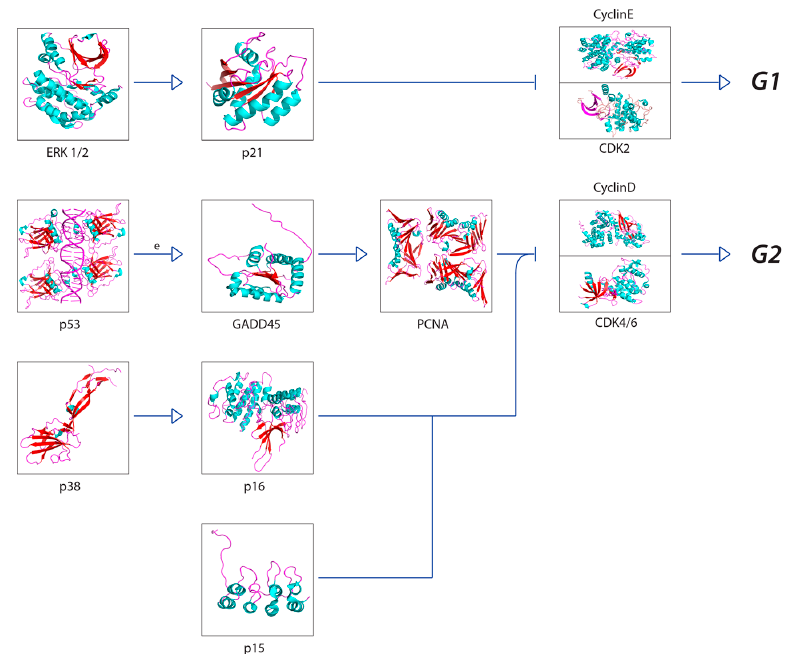
Figure 4. The simplified “cell cycle arrest pathway” downstream of p53 activation. This pathway ties in with the classic MAPK pathway and, therefore, TGF β . This pathway also shows how p53 activation can lead to the expression of p21 and cell cycle arrest. It is important to note that p53 has many functions, and expression can also lead to apoptosis in other circumstances. The protein p21 is also involved in inhibition of other cyclin kinases and subsequent M-phase arrest (not shown) [59–61].